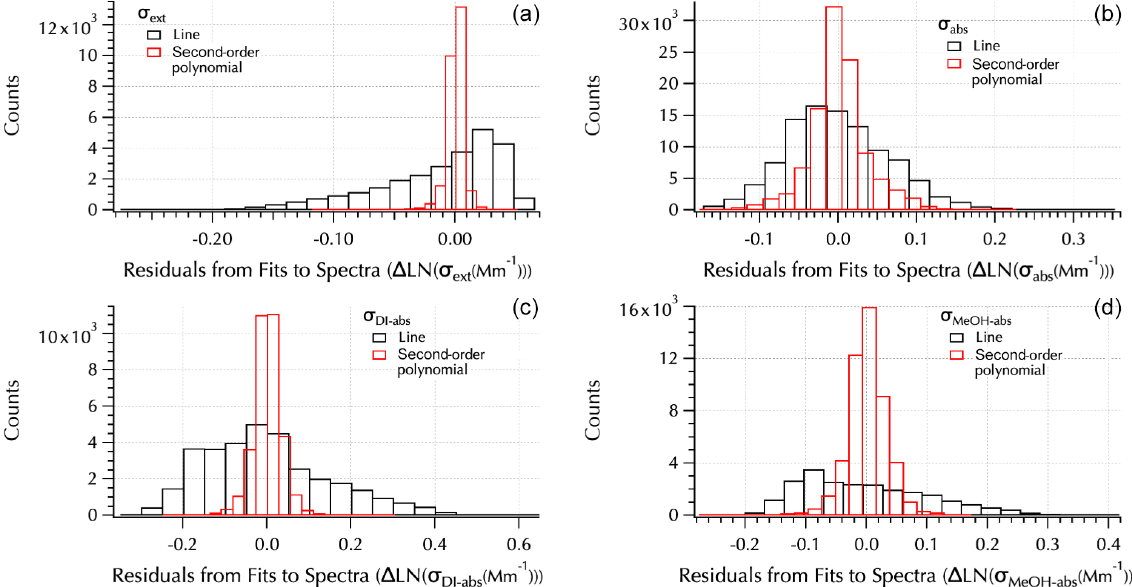
Figure 6. Residuals from linear (black) and second-order polynomial (red) fits to each spectra set: σ ext (a) , σ abs (b) , σ DI-abs (c) , and σ MeOH-abs (d) .